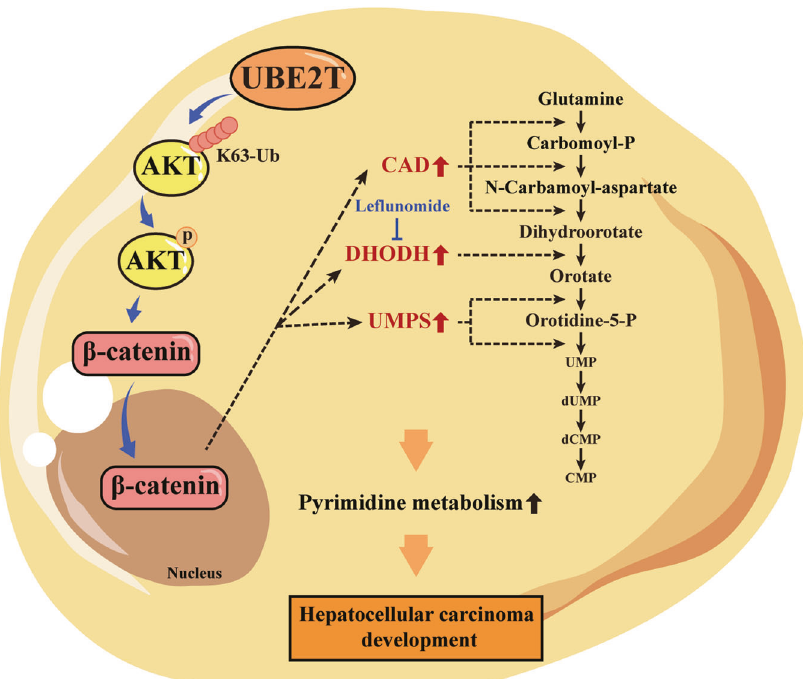
Fig. 8 The schematic of UBE2T-mediated regulation of pyrimidine metabolism and HCC development. UBE2T upregulates Akt K63- ubiquitination and then promotes Akt phosphorylation and activation, thus leading to the nuclear translocation of β -catenin. The UBE2T- induced Akt/ β -catenin axis activation increases the expression of de novo pyrimidine synthesis-related enzymes, including CAD, DHODH, and UMPS, which facilitates the pyrimidine metabolism and hepatocellular carcinoma development. The oncogenic role of UBE2T was impaired by Le fl unomide, which is an inhibitor of